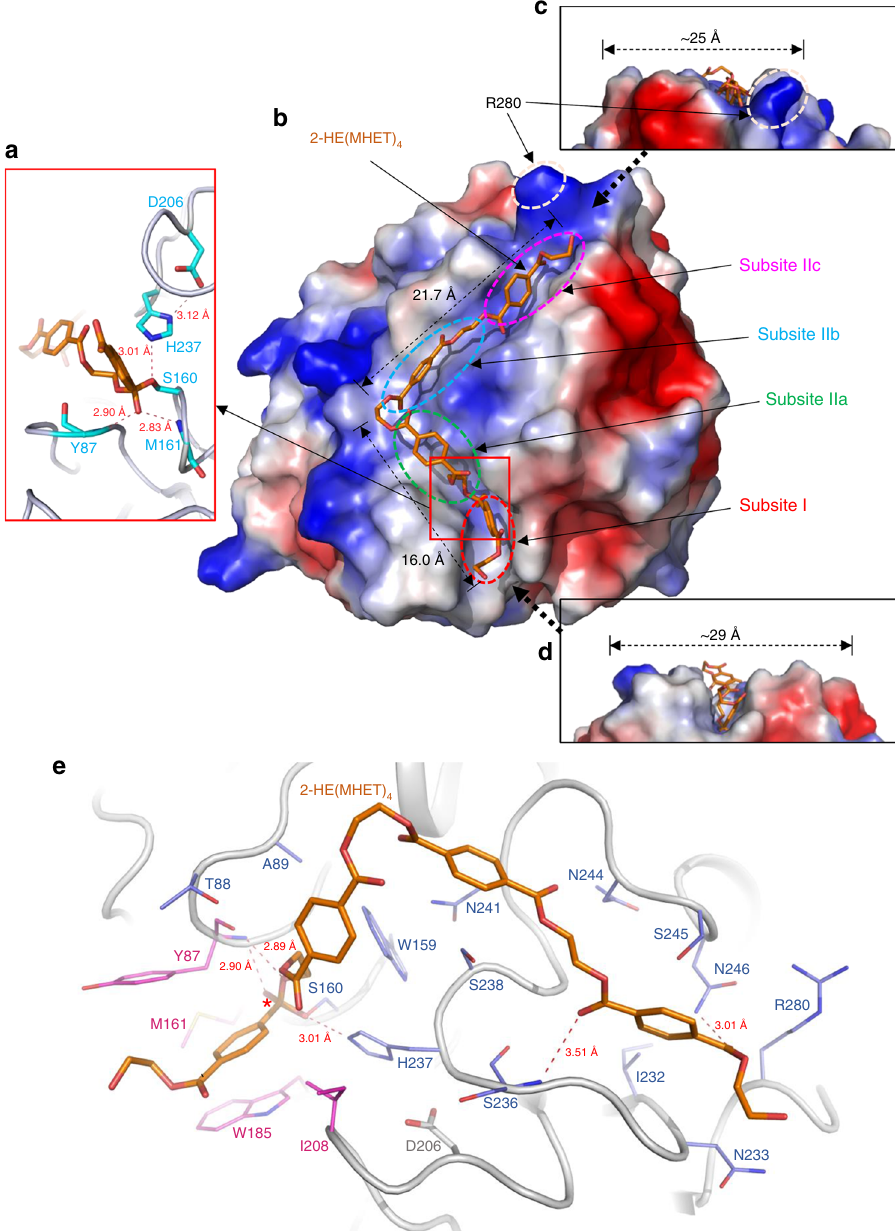
Fig. 2 Active site of Is PETase. a Catalytic triad and the docking model of the reaction intermediate of 2-HE(MHET) 4 in Is PETase. The three residues of Ser160, Asp206 and His237 forming a catalytic triad are shown as cyan-colored sticks and labeled appropriately. The distances of the interaction involved in the oxyanion hole and the catalytic triad are also shown. b Substrate binding site of Is PETase. The Is PETase structure is presented as an electrostatic potential surface model. The 2-HE(MHET) 4 docking model is shown as an orange-colored stick, and the cleavage site is highlighted as a red box. Subsite I, IIa, IIb, and IIc of the substrate binding site are indicated with red, green, cyan, and magenta-colored dotted circles, respectively. Arg280 residue at the end of subsite IIc is also indicated. c , d Side views of the substrate binding mode of Is PETase in b . e Residues involved in the active site of Is PETase. The Is PETase structure is presented as a cartoon diagram with a gray color. Residues involved in binding of 2-HE(MHET) 4 are shown as a line model, and those constituting subsite I and subsite II are distinguished with colors of magenta and light-blue, respectively, and the ester bond that is cleaved by the enzyme is indicated with a star mark. The 2-HE(MHET) 4 docking model is shown as an orange-colored stick. The hydrogen bonds formed between the residues and the substrate are shown as red-colored